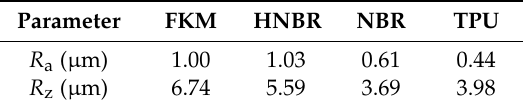
Table 5. The average roughness ( R a ), mean roughness depth ( R z ) of uncoated samples. Parameter